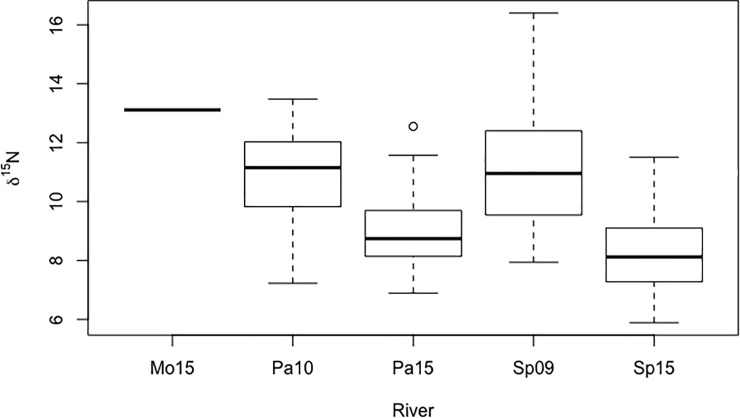
Boxplots for 𝛿15N in fecal samples from Neotropical river otters in Guatemala.Mo16 = samples from Mopan River 2016 (n = 1); Pa10, Pa15 = samples from Pasion River 2010 and 2015 (n = 36 in 2010 and n = 34 in 2015); Sp09, Sp15 = samples from San Pedro River 2009 and 2015 (n = 20 in 2009 and n = 55 in 2015).